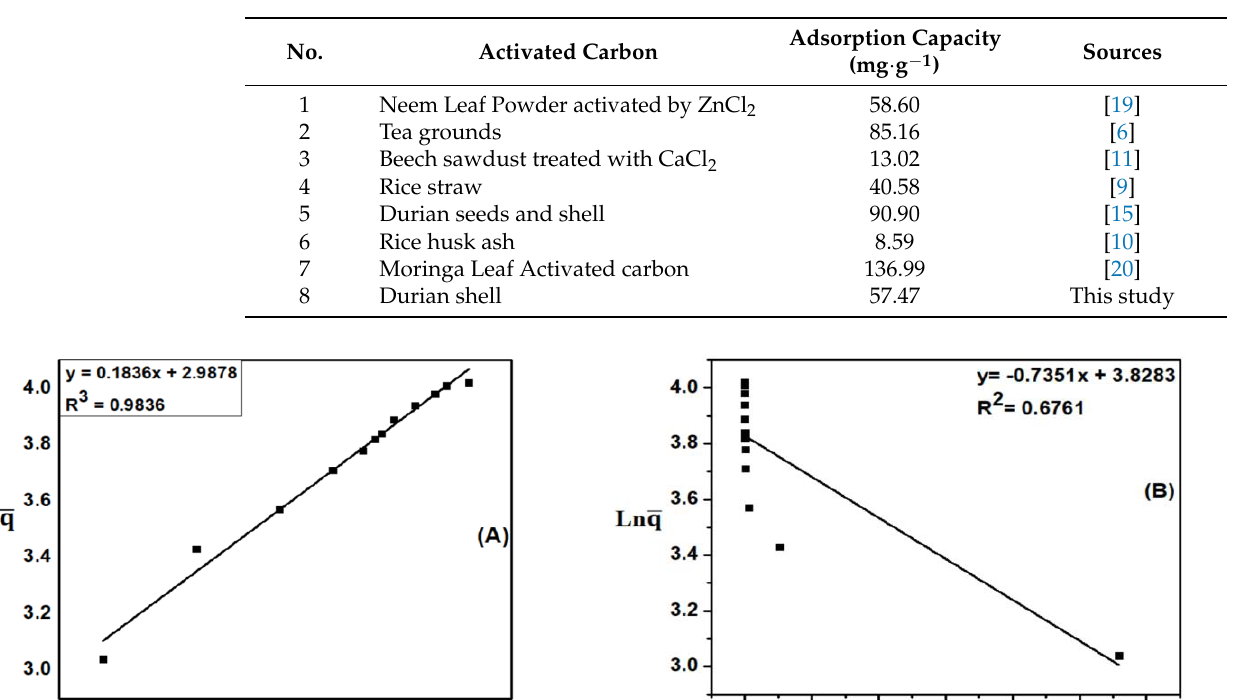
Figure 11. ( A ) The dependence of q̅ on ln C cb ̅̅̅̅ according to the Tempkin model and ( B ) The de- pendence of ln ( q̅ / C cb ̅̅̅̅ ) on q̅ according to the Elovich isotherm adsorption model. 3.5.5. Elovich Isotherm Model The Elovich isotherm model is applied to the multilayer adsorption process. The results of calculation are shown in Figure 11B, with q max = 8.42 mg·g −1 . Table 5 is a sum-